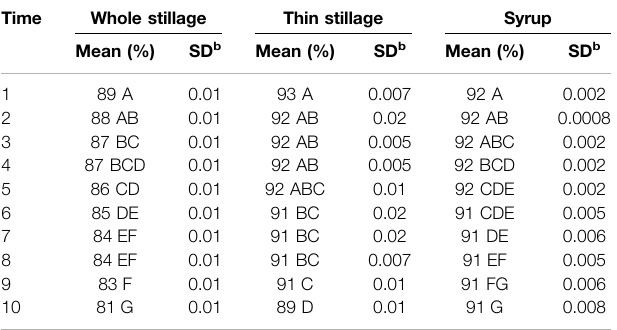
TABLE 3 | Moisture contents of three coproducts over time. a